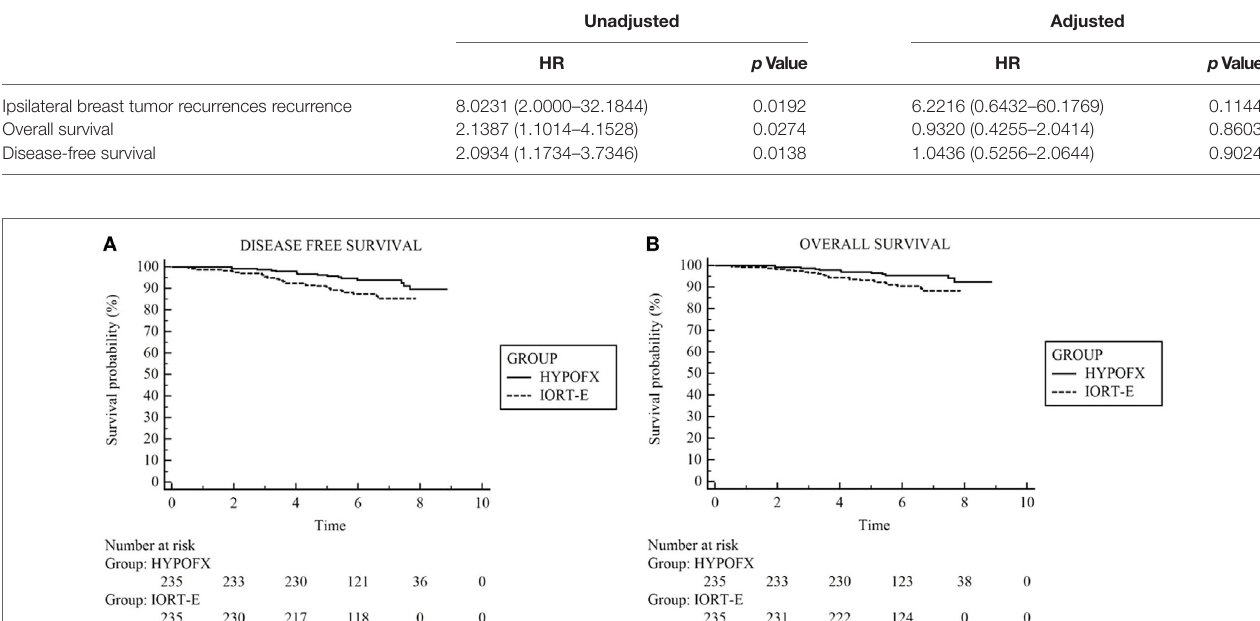
FigUre 2 | The disease-free survival and overall survival (OS) using Kaplan–Meier method. (a) Disease-free survival, (B)